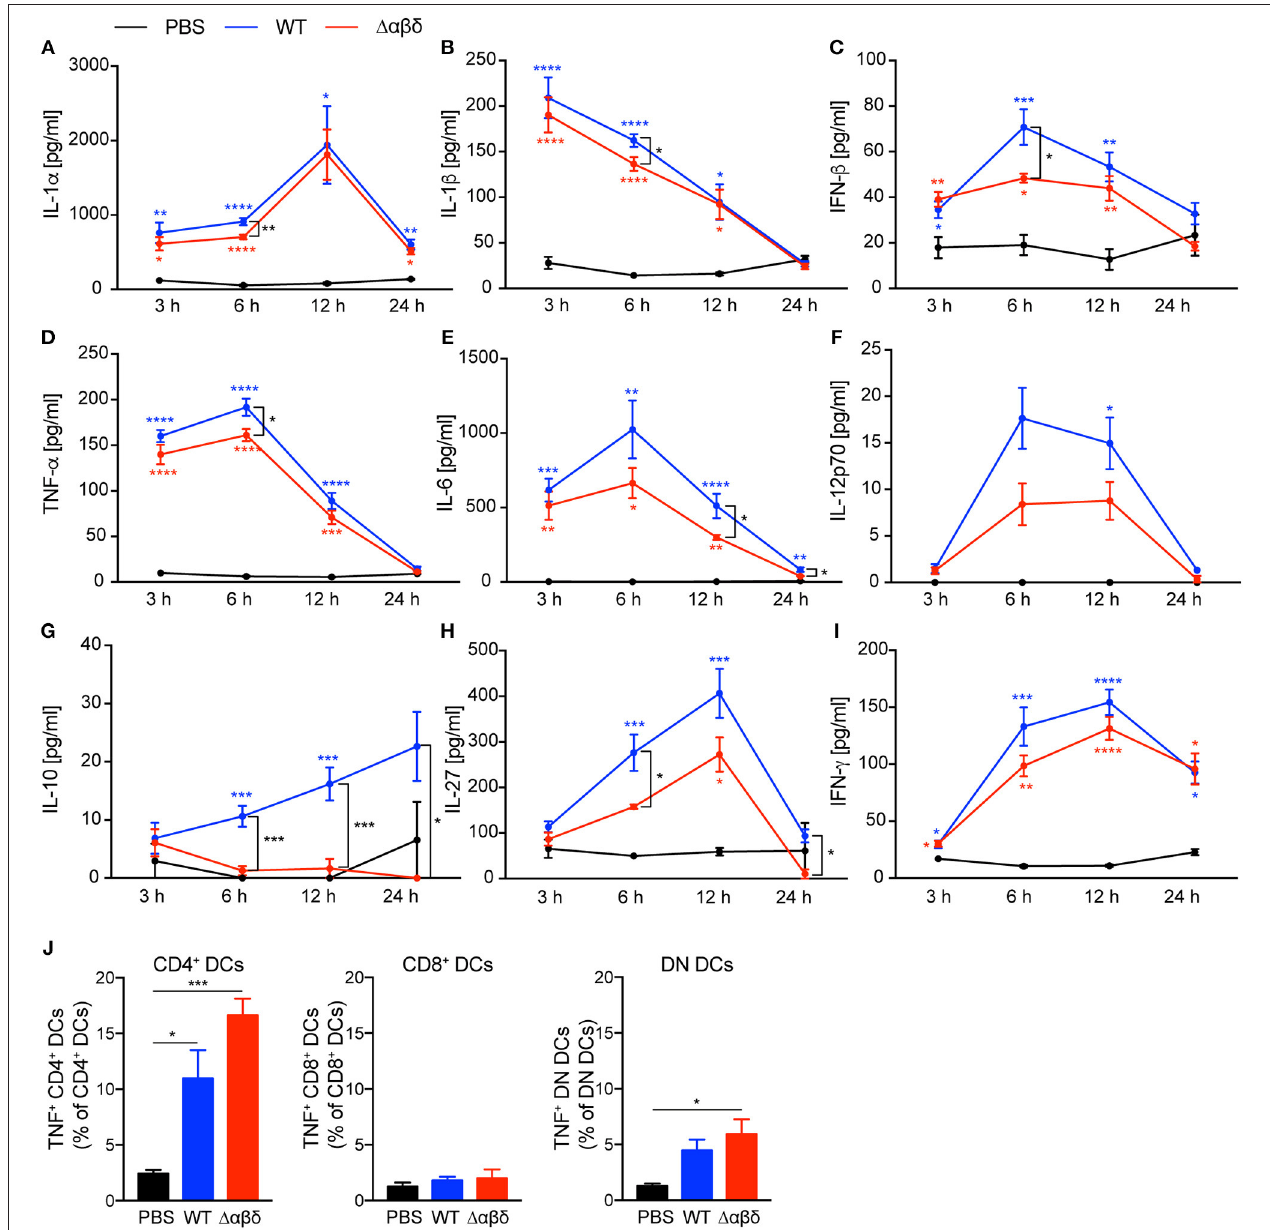
FIGURE 3 | S. aureus PSMs modulate the pro-inflammatory and anti-inflammatory cytokine response upon in vivo infection. C57BL/6J WT mice were either treated with PBS or infected with S. aureus USA300 WT or the PSM-deficient S. aureus USA300 1 αβδ mutant strain for up to 24h. At the indicated times spleen homogenates were analyzed for (A) IL-1 α , (B) IL-1 β , (C) IFN- β , (D) TNF- α , (E) IL-6, (F) IL-12p70, (G) IL-10, (H) , IL-27, and (I) IFN- γ by a multiplex bead array. The graphs represent the mean ± SEM with data from one or data pooled from multiple experiments; quantity of mice and experiments per condition and time is depicted in Table S2 (one-way ANOVA followed by Tukey’s post-hoc test; * p < 0.05, ** p < 0.01, *** p < 0.001, and **** p < 0.0001; blue * describe differences between PBS and S. aureus USA300 WT, red * describe differences between PBS and S. aureus USA300 1 αβδ , and black * describe differences between S. aureus USA300 WT and USA300 1 αβδ ). (J) Graphical summary of the frequencies of TNF + cells among DC subsets in the spleen of PBS-treated or infected mice (mean ± SEM of five mice from one experiment; one-way ANOVA followed by Tukey’s post-hoc test; * p < 0.05 or *** p < 0.001).